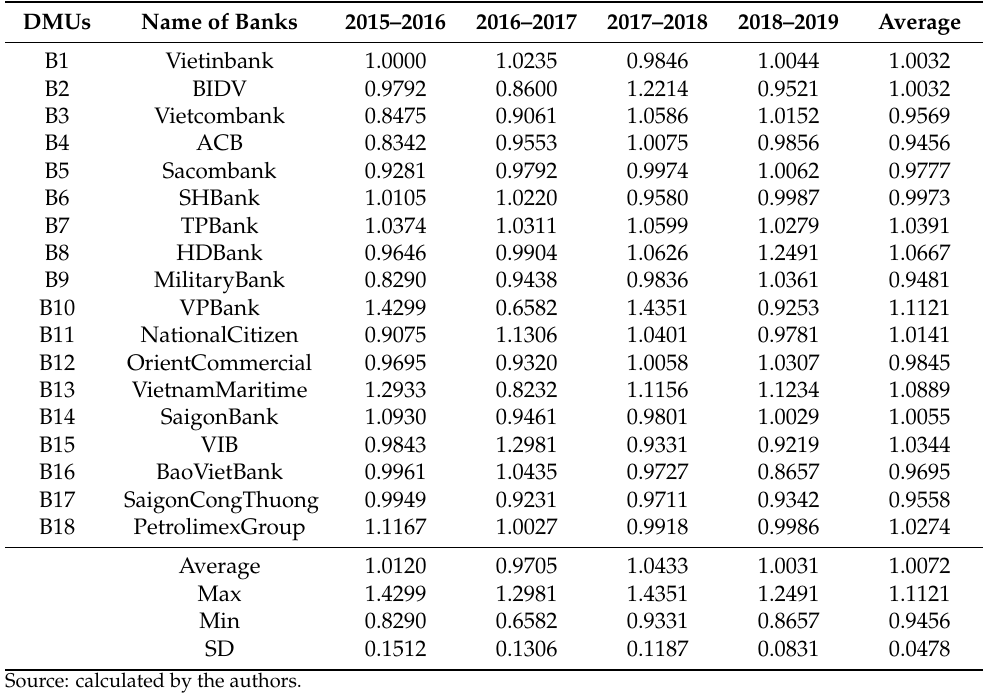
Table 5. The technical efficiency change indexes.